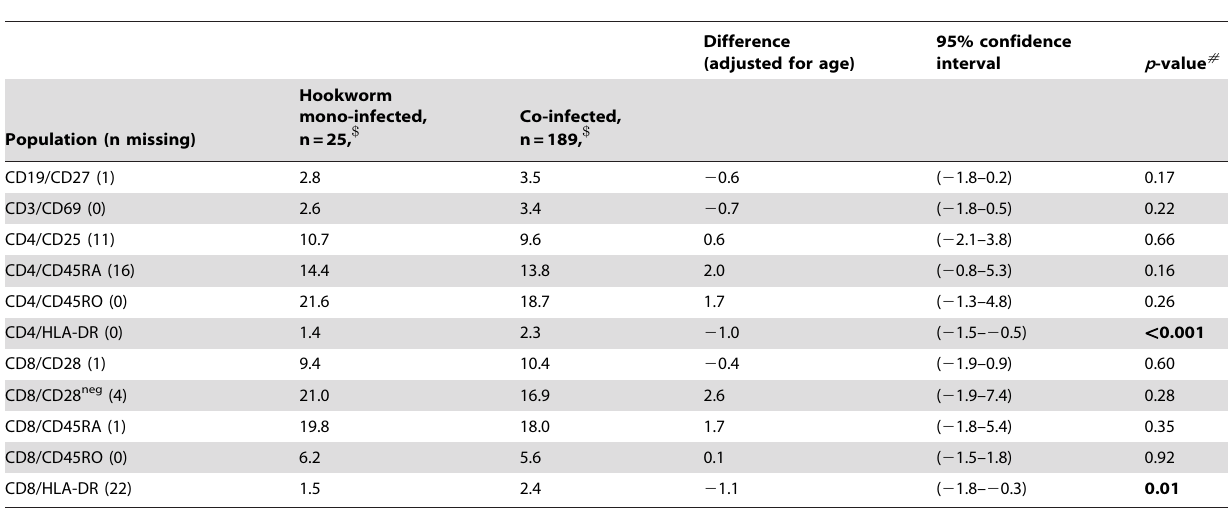
Table 2. Cell surface markers on PBMC from hookworm mono- and co-infected individuals.